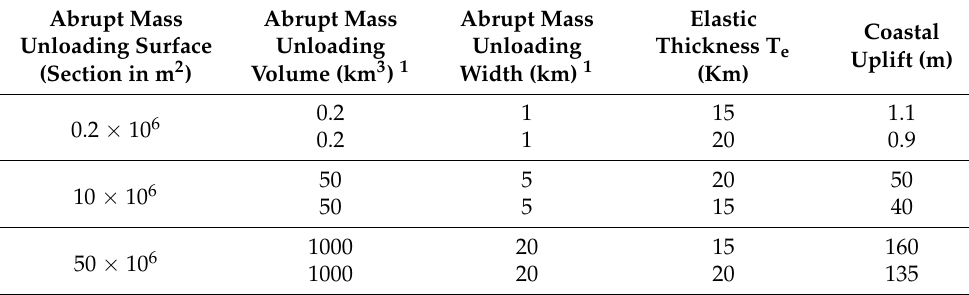
Table 2. Summary of main modeling results.